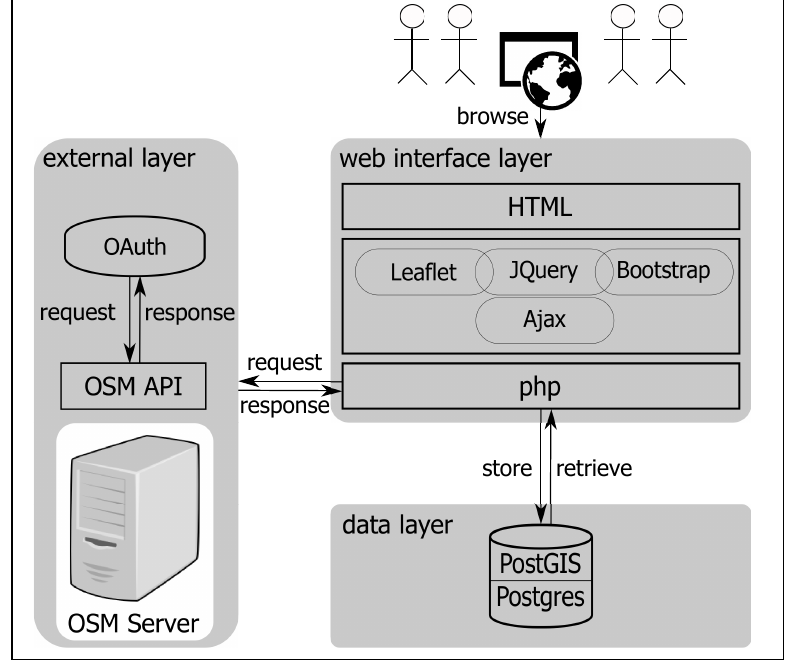
Figure 7. The Grass&Green application